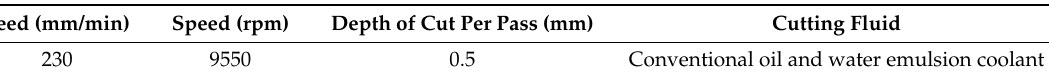
Table 3. Roughing machining parameters. Table 4. Roughing strategies information.